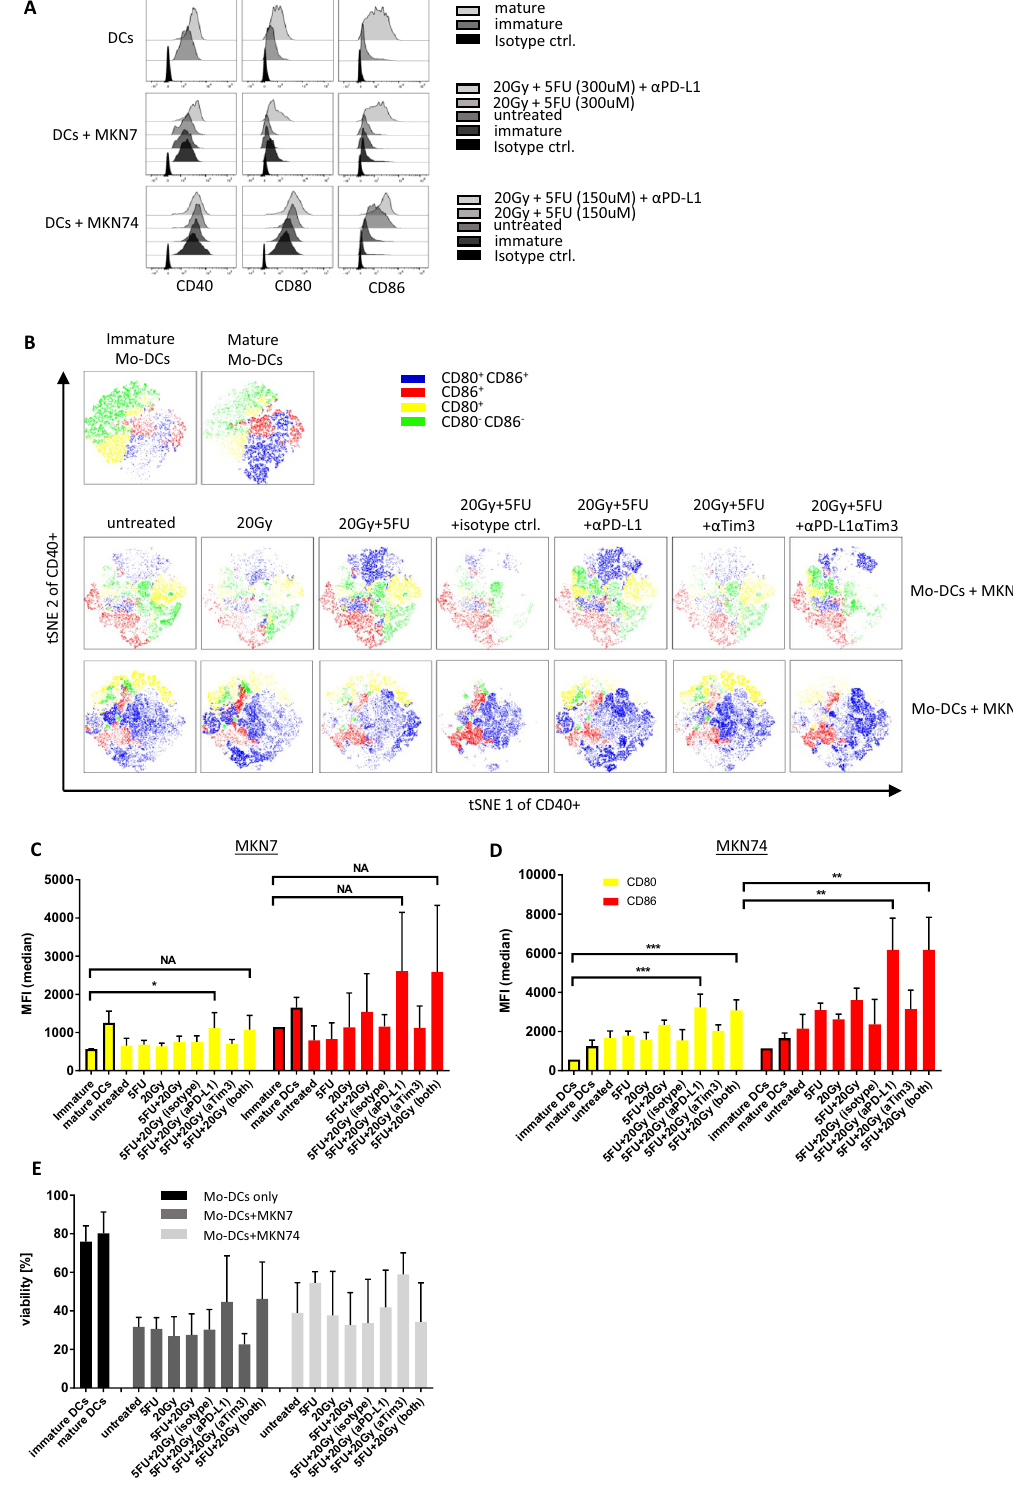
Figure 4. MKN7 and MKN74 induce maturation in DCs after chemo-/radiation treatment. MKN7 and MKN74 were treated using 150 μM or 300 μM of 5FU, 20 Gy of X-ray irradiation or chemoradiation. After 48 h of culture they were combined with immature Mo-DCs isolated from PBMCs. ( A ) Surface protein staining of Mo-DCs after 72 h of co-culture, ( B ) tSNE analysis of concatenated replicates of Mo-DCs co-cultured with either MKN7 or MKN74 cells, ( C , D ) bar graphs of MFI of surface proteins staining in Mo-DC co-cultured with either MKN7 or MKN74, respectively, ( E ) bar graph of viability of Mo-CDs. Bar graphs display the mean and SEM of at least 3 biological replicates. *P < 0.05, **P < 0.01, ***P < 0.001, NA not